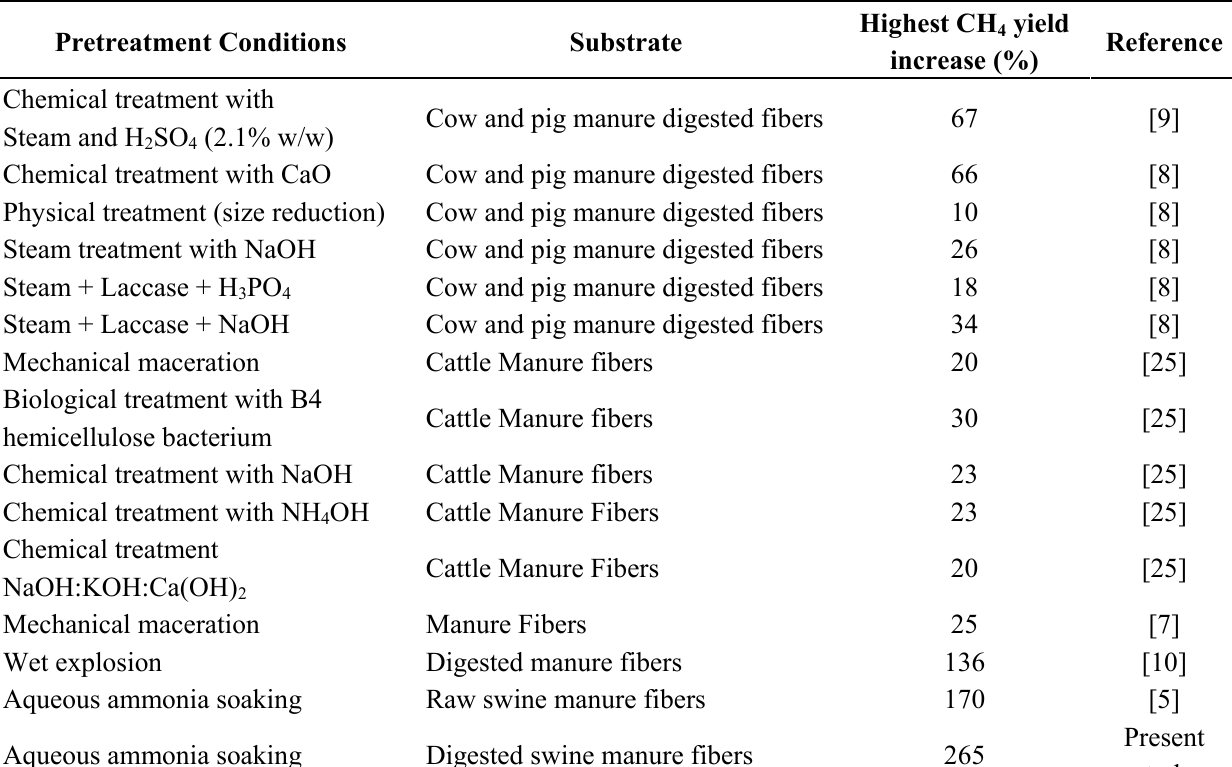
Table 2. Treatments applied on manure fibers and the corresponding maximum methane yield